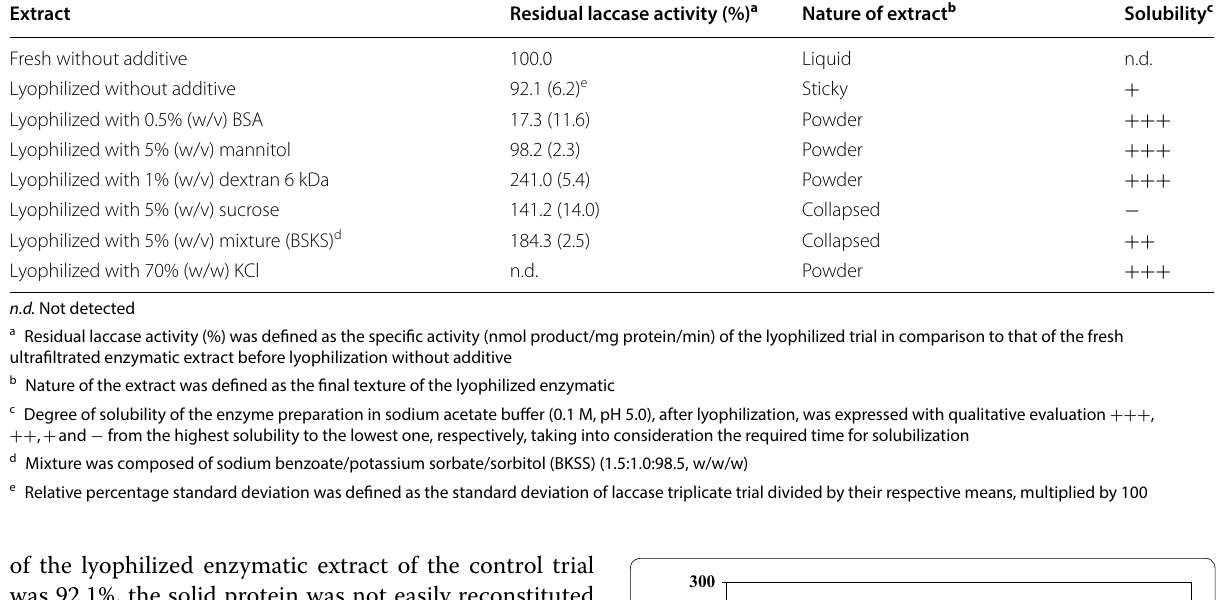
Table 1 Effect of different lyoprotectants on laccase stability, nature of the extract and its solubility